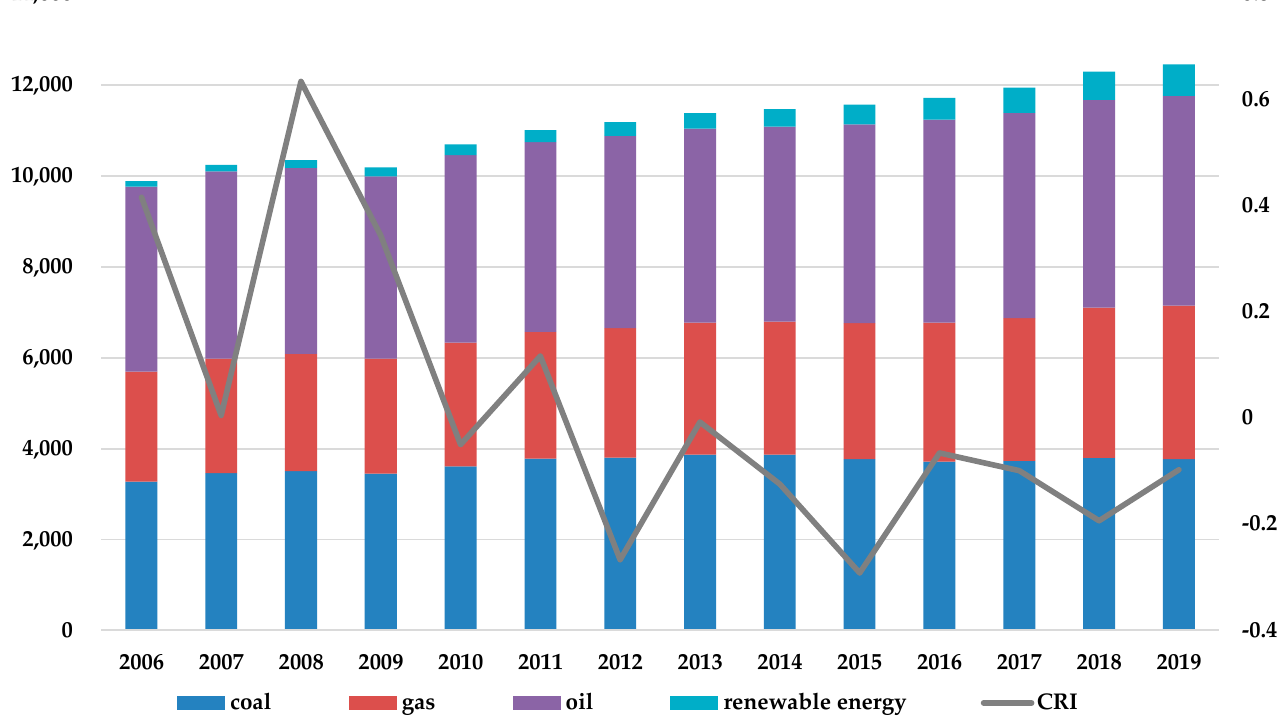
Figure 2. Changes in energy consumption structure and climate risk index.